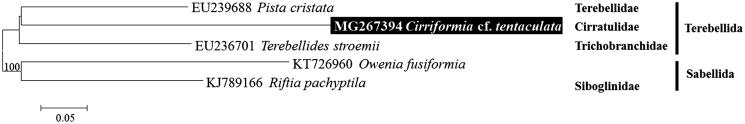
Neighbour-joining (NJ) tree based on the mitogenome sequences of Cirriformia cf. tentaculata with two other related species in Terebellida. Owenia fusiformis and Riftia pachyptila derived from Sabellida were used as outgroup for tree rooting. Numbers above the branches indicate NJ bootstrap values from 1000 replications.